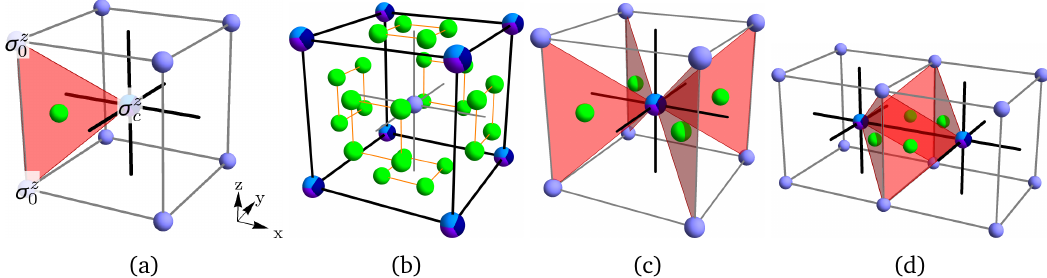
Figure 5: Gauging planar symmetry on BCC lattice. (a) A minimal symmetric cou- pling term: a product of two σ z and one σ z . The black lines form the cubic lattice, c 0 while the gray lines form the dual lattice. There are 12 minimal coupling terms within the shown dual-lattice cube: one for each gray edge of the cube. For the other terms, the σ z at the center becomes a σ z or σ z when the two σ z are displaced in c a 0 b the x or y direction, respectively. (b) The body-center is involved in 4 × 6 minimal coupling terms, which are centered at the green spheres, which lie on the faces of the black cube. (The orange lines are guides for the eye.) The gauge symmetry term is therefore a product of a σ x at the center and 24 τ x on the green spheres. (c) The σ z c operator in the center is involved in 4 minimal coupling terms (highlighted in red). The gauge symmetry term is therefore a product of a σ x at the center and four τ x c on the green spheres. (d) The product of the four minimal coupling triangular terms is the identity. The corresponding flux term is a product of four τ z on the four green